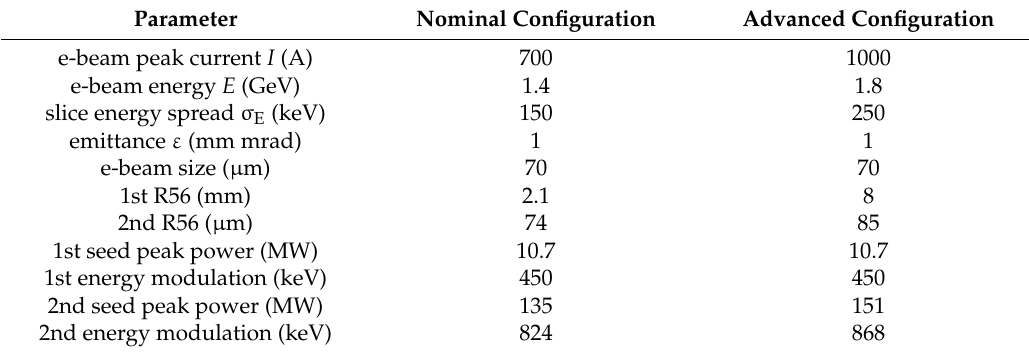
Table 1. Typical EEHG operating parameters in the nominal (middle column) and advanced (right column) configurations. Parameter Nominal